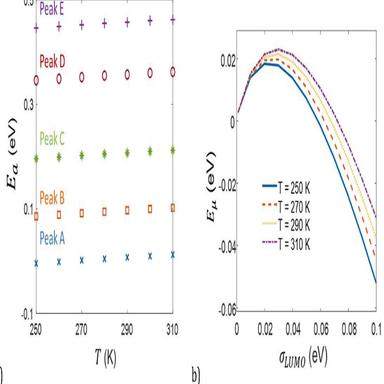
a) Evolution of the extracted activation energies with the temperature for each trap contribution. b) Evolution of the transport energy Eμ with temperature for low carrier concentration and the mean Eμwith σLUMO in the inset.